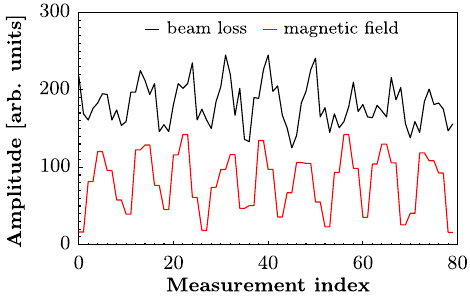
FIG. 26. Correlation between the signal of the slow BLM16 and the amplitude variation of the 5 kHz component of the main magnetic field using TPS15 and SMH16 in shadowing